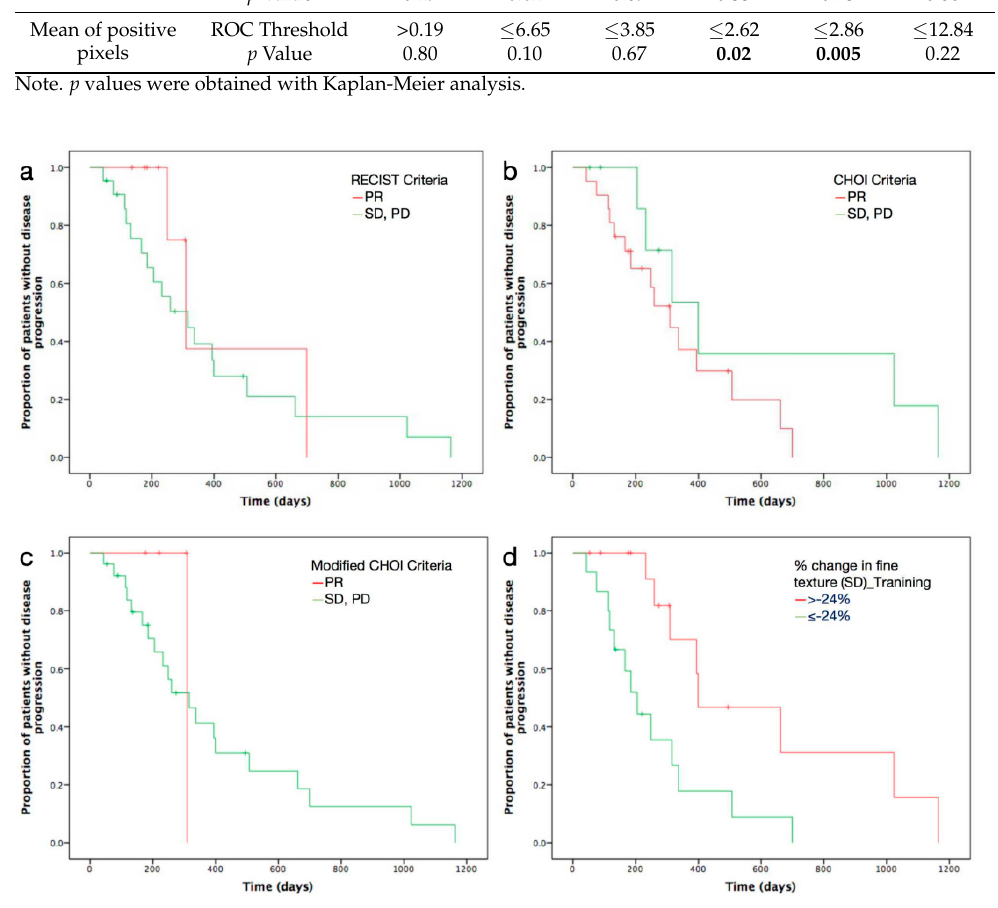
Table 6. ROC and Kaplan-Meier analysis for percentage change in texture parameters at different scale values.